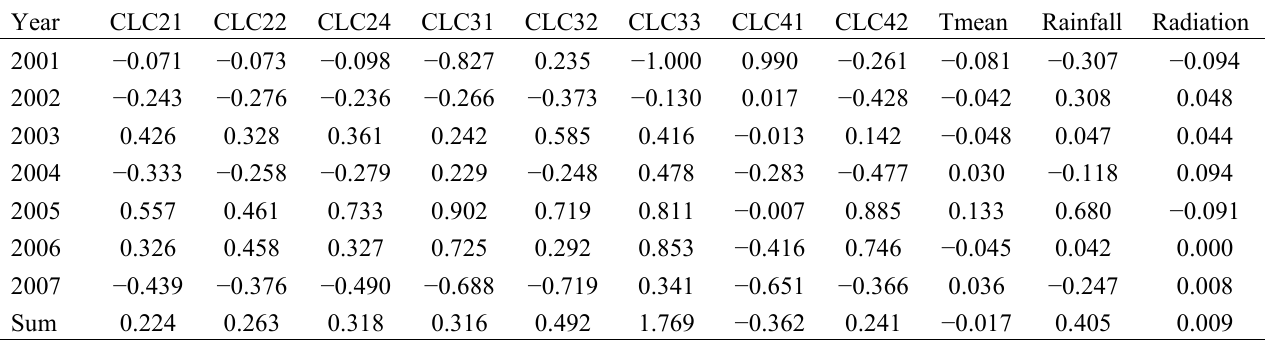
Table 4. Normalized ratio of negative-positive anomalies (normalized D/S coefficient) of annual EVI time series